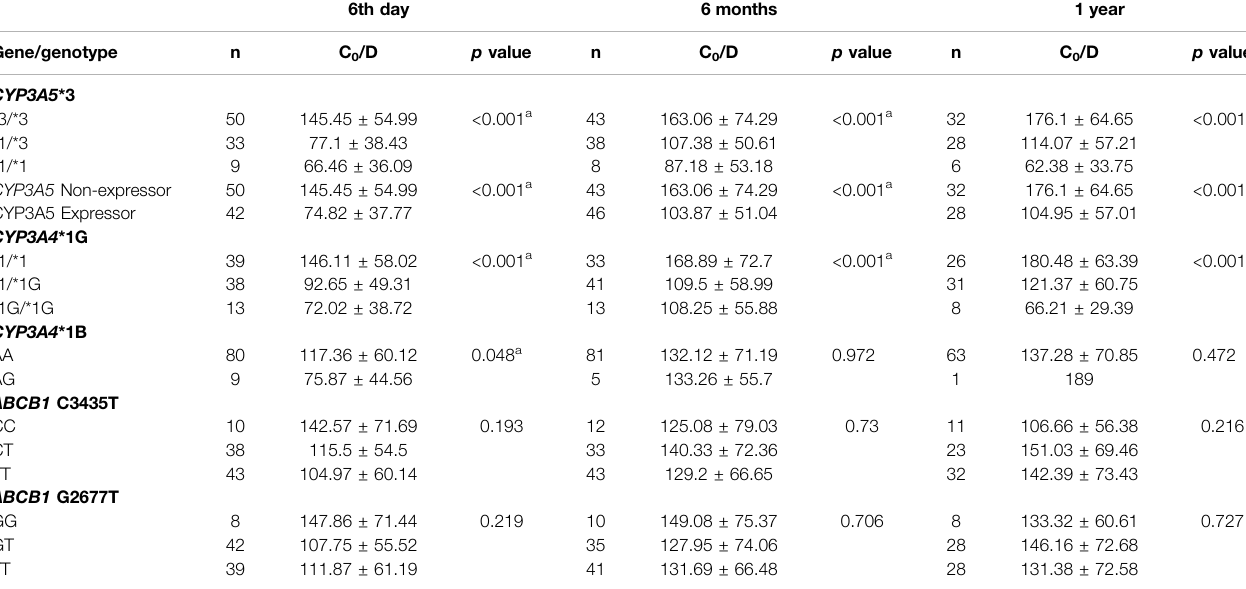
TABLE 4 | Association of SNP genotypes with tacrolimus C 0